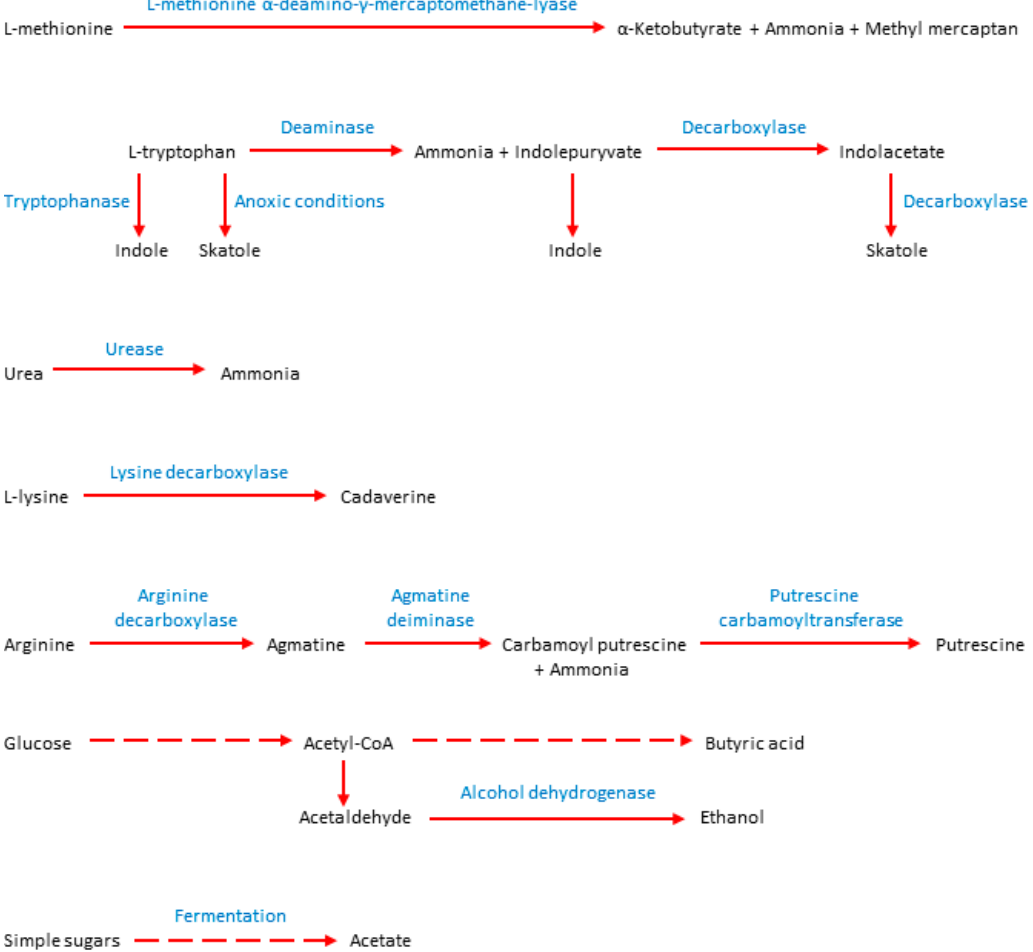
Figure 2. Simplified ways of bacterial production of selected odorous compounds [30,75,76,96–102].